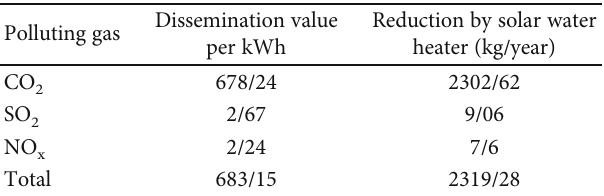
Table 3: The amount of reduction in pollutant gases through the use of solar water heater